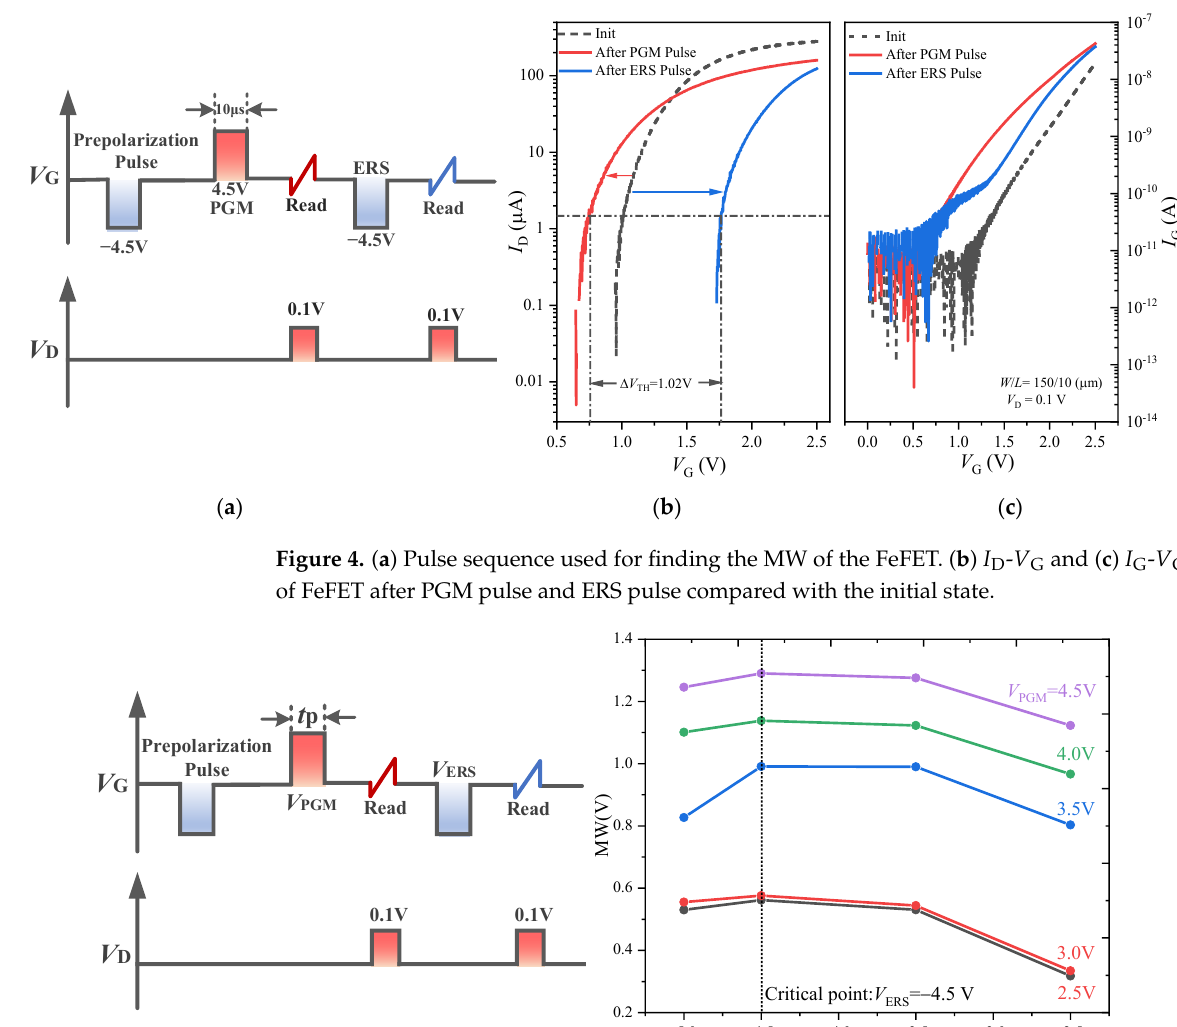
T to decrease. This is because the polarization state of the ferroelectric